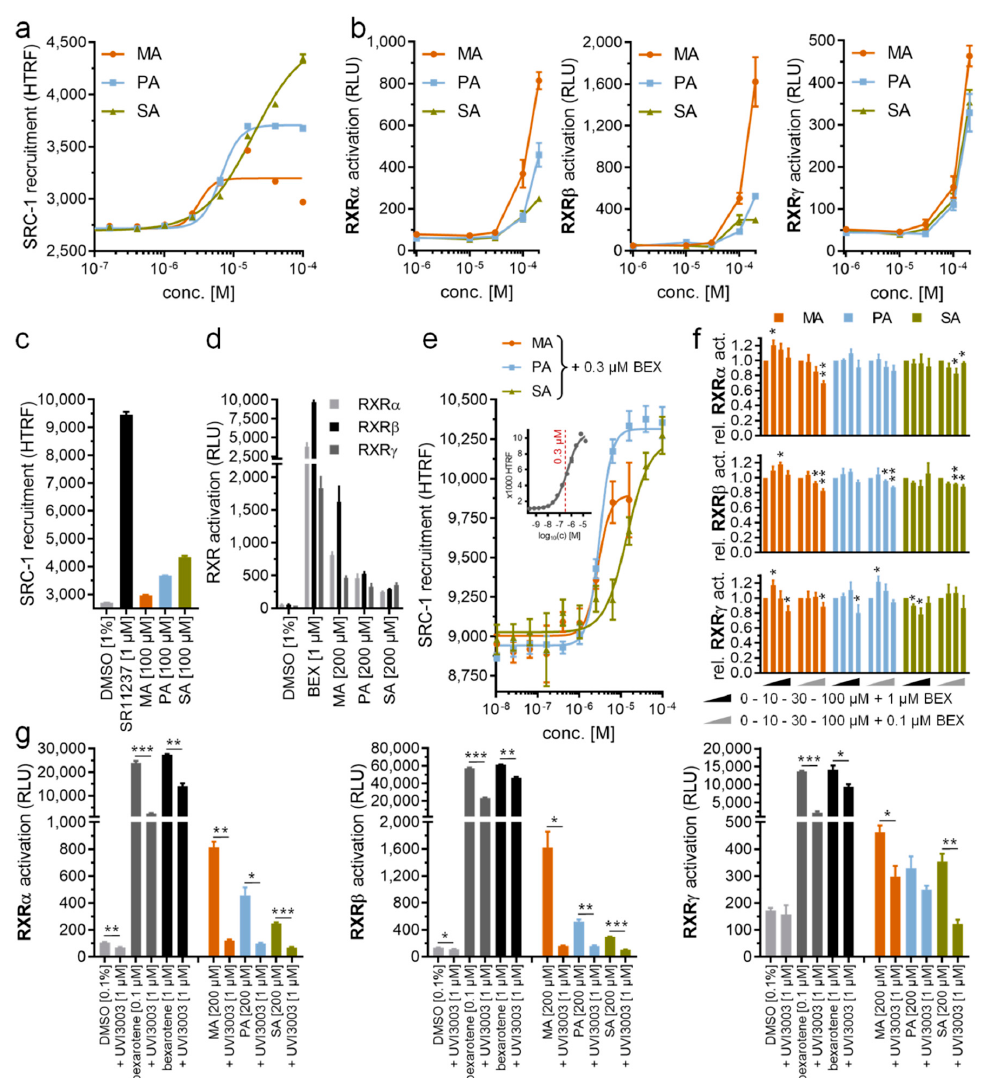
Figure 5. In vitro characterization of saturated fatty acids as RXR ligands. ( a ) Myristic acid (MA), palmitic acid (PA) and stearic acid (SA) dose-dependently induced steroid receptor co-activator 1 (SRC-1) recruitment to the RXR α LBD in a HTRF-based assay with low micromolar potencies. ( b ) MA, PA and SA activated RXR α , RXR β and RXR γ in cellular reporter gene assays at 100 µM concentration and above. ( c , d ) Efficacy of saturated fatty acids in promoting SRC-1 recruitment to the RXR α LBD (c) and in activating RXR in a cellular setting (d) was low compared with the synthetic agonists, SR11237 and bexarotene. ( e ) In the presence of 0.3 µM bexarotene (~EC 50 ), MA, PA and SA showed no competitive behavior, but caused enhanced SRC-1 recruitment at higher concentrations. Inset shows dose response of bexarotene in the same setting with the 0.3 µM concentration used for competition experiments highlighted in red. ( f ) At a low concentration (10 µM), saturated fatty acids showed a tendency to promote bexarotene (0.1 µM or 1 µM)-induced RXR activation in Gal4 hybrid reporter gene assays too, while weak competitive behavior was observed at a higher concentration (100 µM). ( g ) RXR activation by MA, PA and SA (200 µM each) in the cellular reporter gene assay was blocked by the RXR antagonist, UVI3003. All data are mean ± SEM values, n = 3. * p < 0.05, ** p < 0.01, *** p < 0.001 (t-test vs. bexarotene alone ( f ) or as indicated ( g ))